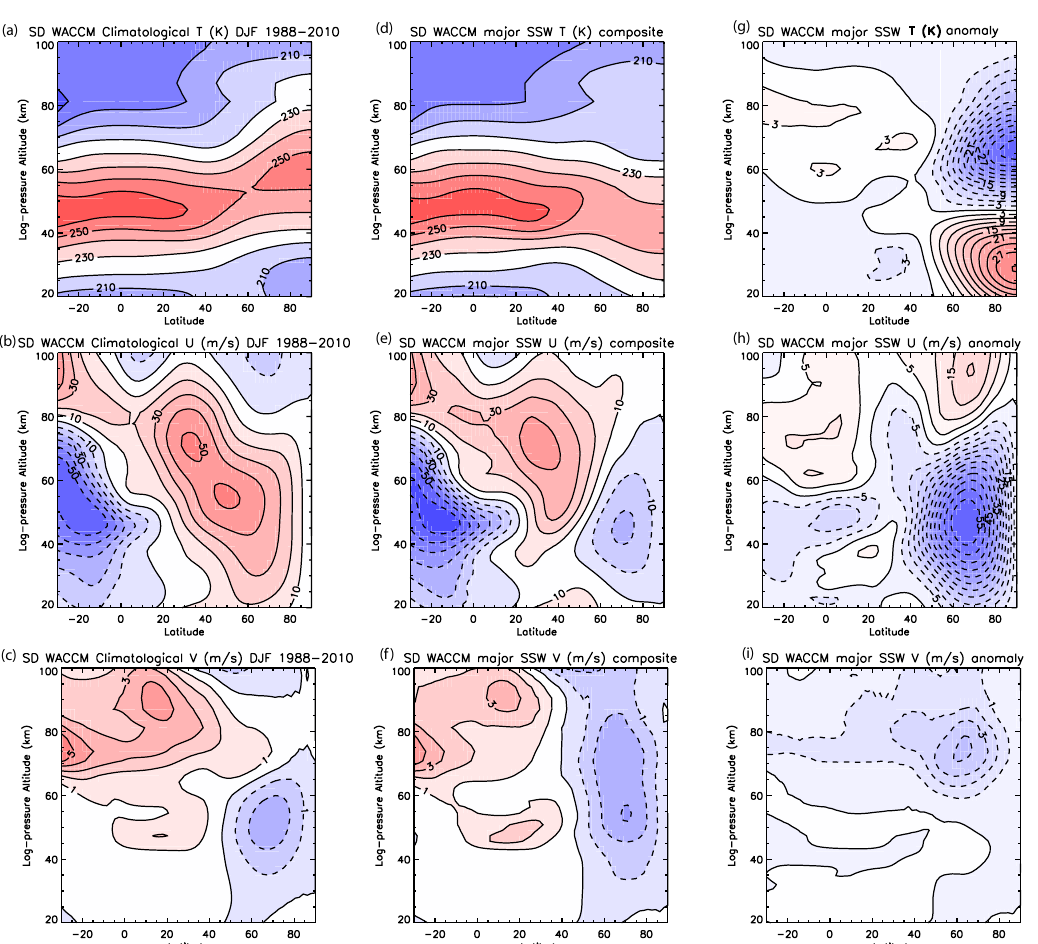
Figure 1. The climatological average zonal-mean (a) temperature ( T ), (b) zonal wind ( U ) and (c) meridional wind ( V ) between December and February from 1988 to 2010, the zonal-mean (d) temperature (e) zonal wind and (f) meridional wind during seven days centered around 10 major SSW events between 1988 and 2010 event and the zonal-mean anomalies from climatological mean during the composite SSW event in (g) temperature (h) zonal wind and (i) meridional